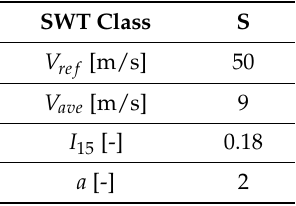
Table 1. Basic parameters of the vertical wind turbine.